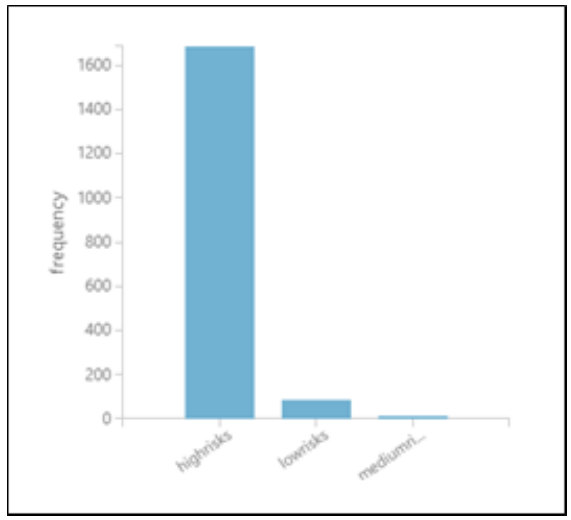
Figure 23. Performance evaluation of the risk model for employee churn.